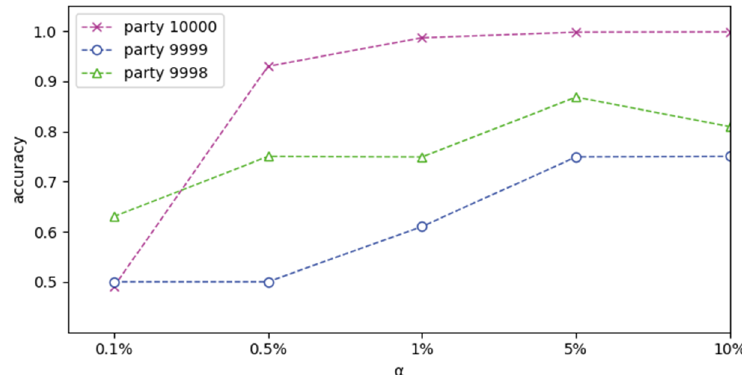
Figure 9. Growth trend of accuracy with γ .